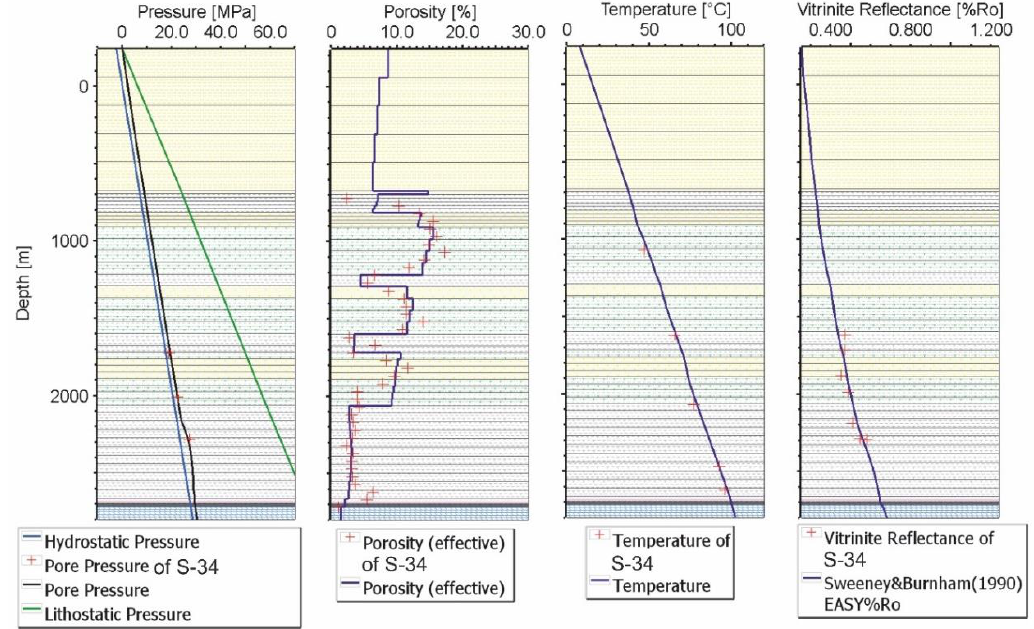
Figure 8. Exemplary results of Miocene sedimentary basin model calibration with well data of (from left to right) pore pressure, porosity, temperature, and vitrinite reflectance. Red crosses represent calibration data in borehole profile, while continuous curves represent the model responses.